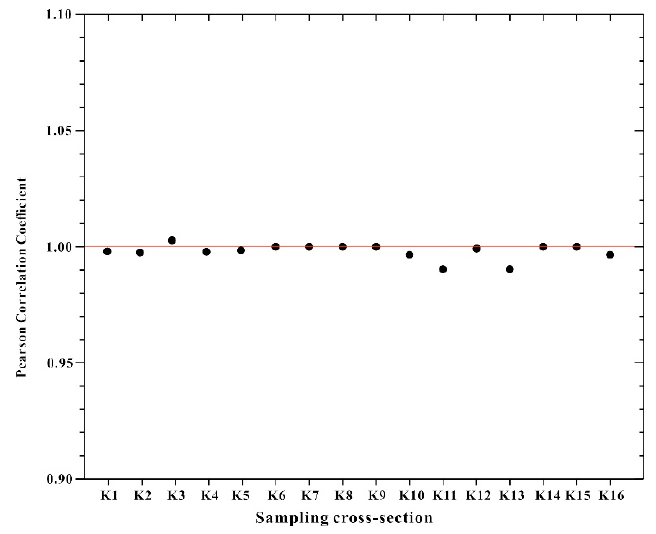
Figure 5. Pearson correlation coefficient of PTEs concentration in river waters vs. in sediments.